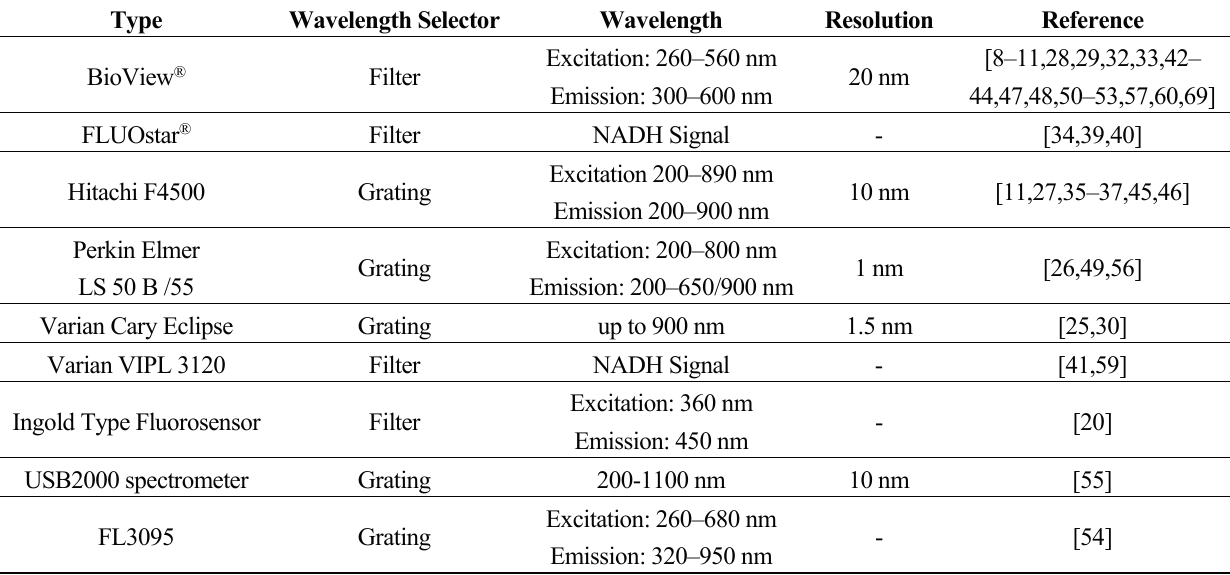
Table 3. Fluorescence sensors applied for bioprocess